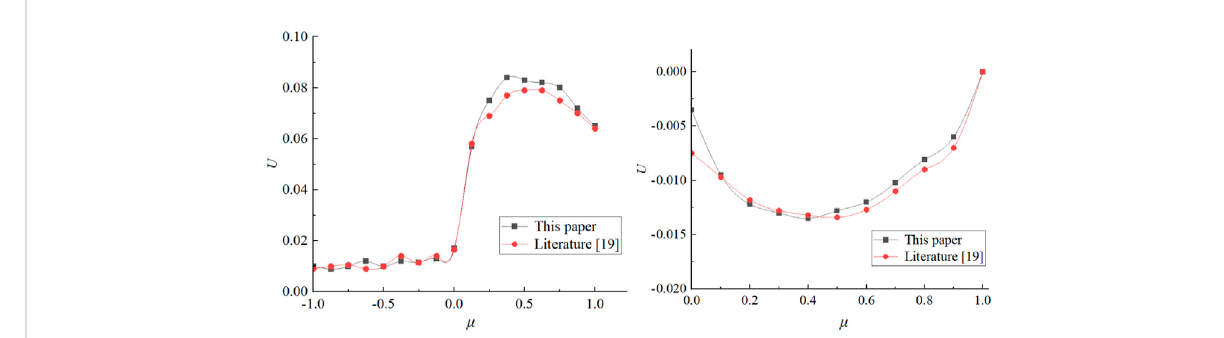
FIGURE 2 Values of I (left) and V (right) components at an Angle of 90 ° at the bottom of the atmosphere.